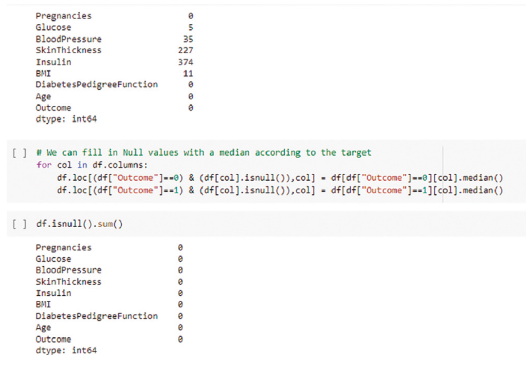
Figure 7: Accuracy percentage during simulation, process 1.